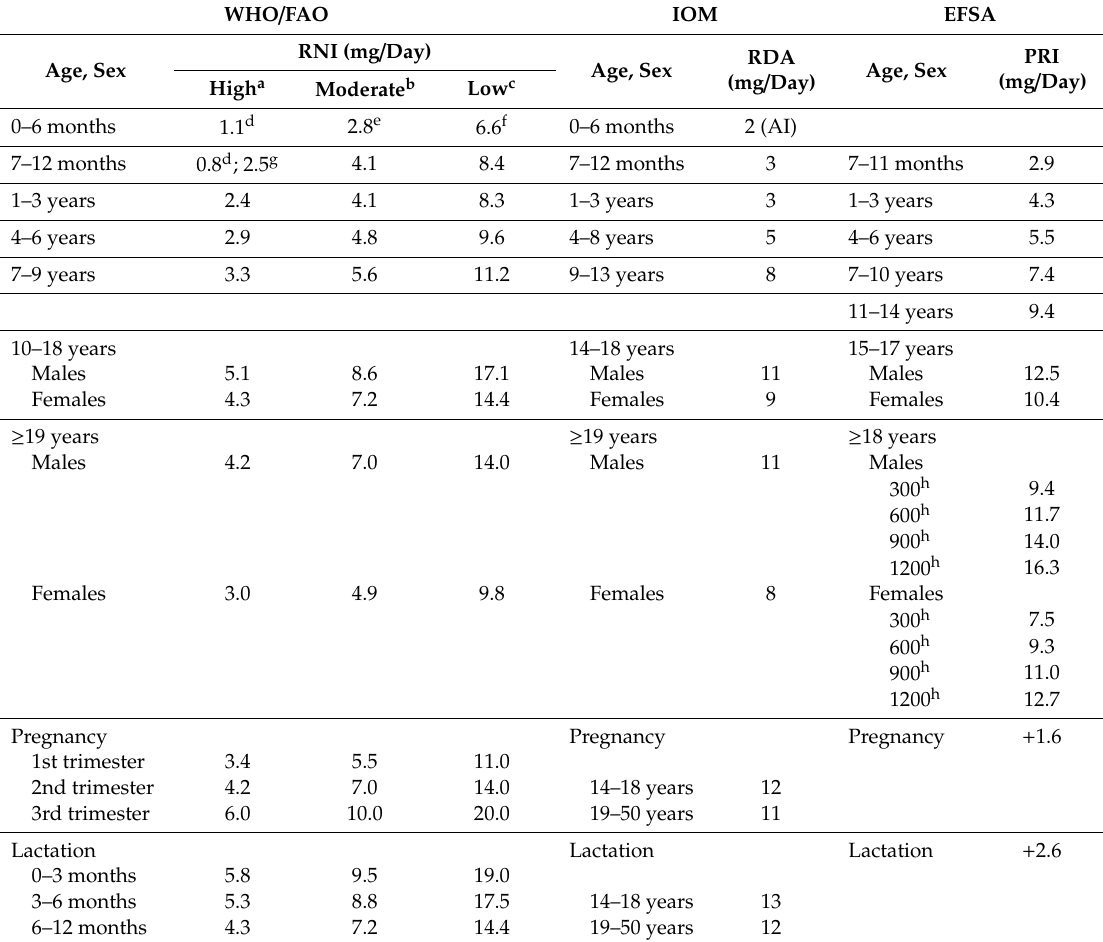
Table 1. Zinc dietary recommendation according to WHO / FAO, IOM and EFSA